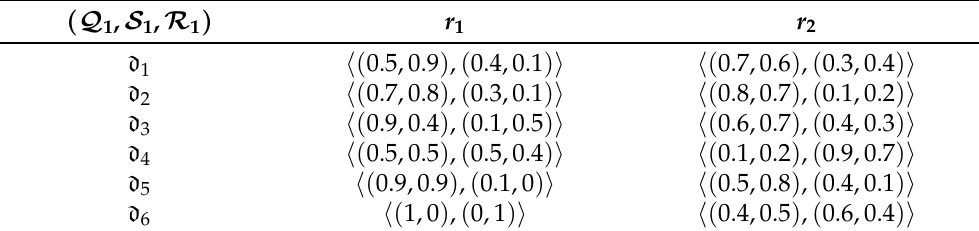
Table 6. Table for the 7-ROFBSS ( Q 1 , S 1 , R 1 ) .